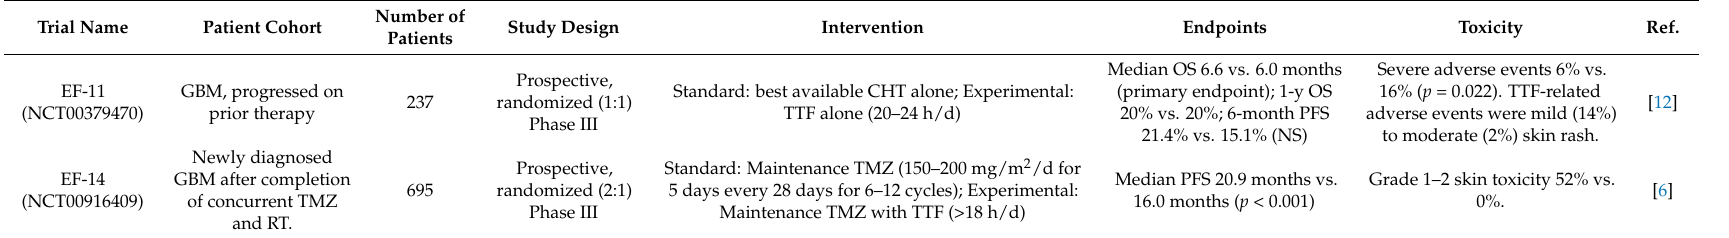
Table 1. Completed clinical trials using tumor treating fields (TTF) for glioblastoma (GBM), published 1 .